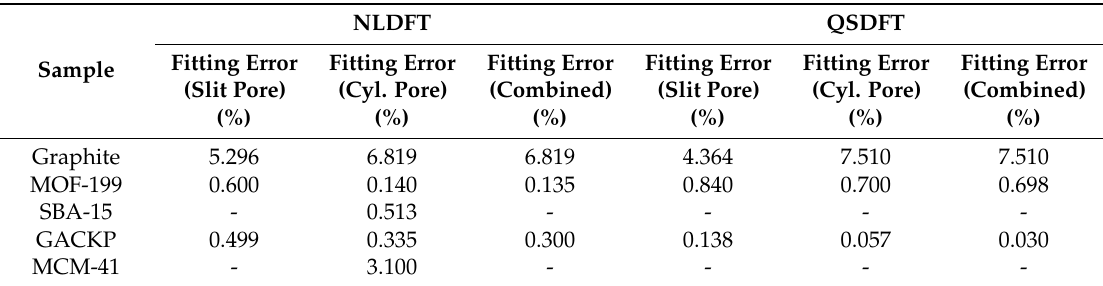
Table 2. Mean error adjustments between different surface textures (NLDFT vs. QSDFT) in pores slit and slit/cylindrical for the samples prepared in this research.